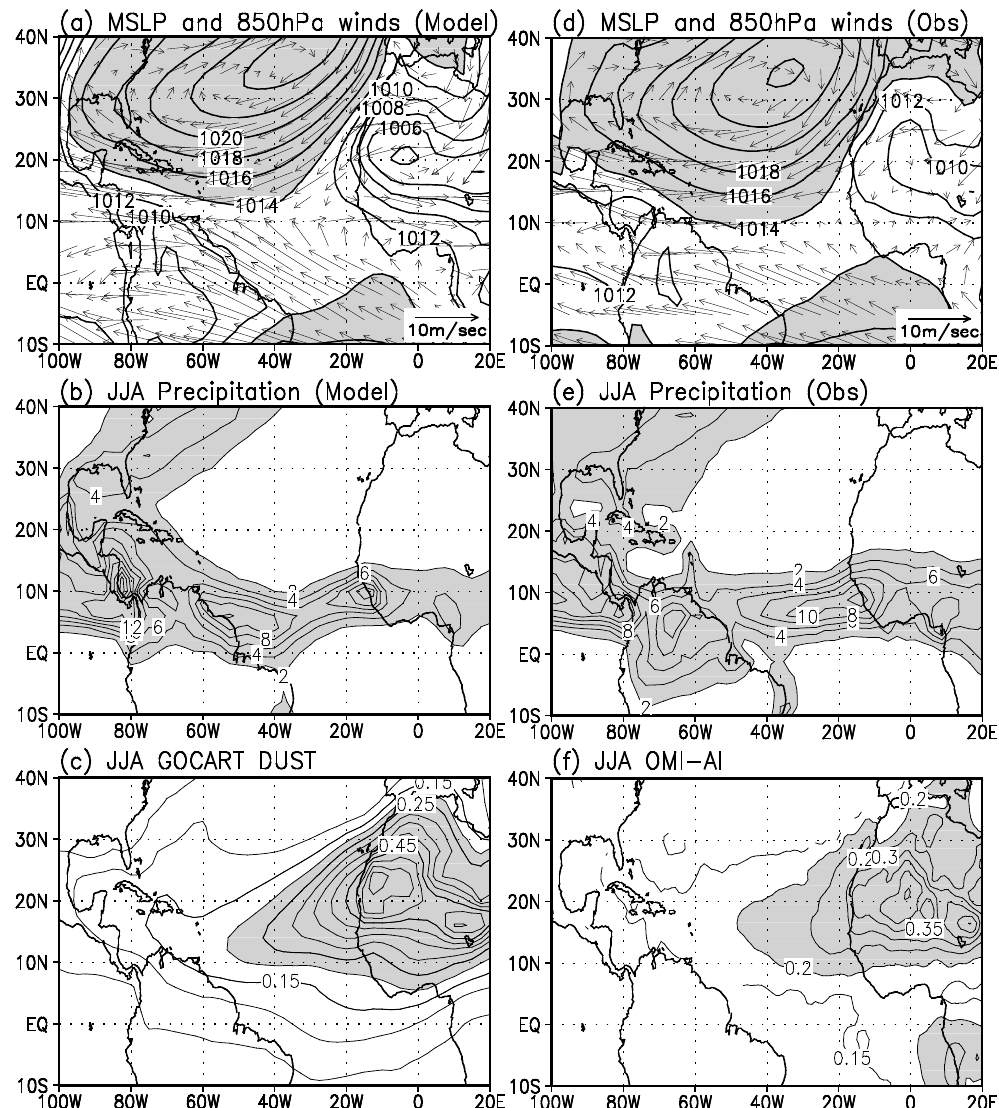
Fig. 1. JJA model climatology of (a) 850hPa wind (ms − 1 ) and mean sea level pressure (hPa), (b) rainfall (mm day − 1 ) from control run (AA), compared with corresponding observation climatology from NCEP reanalysis and GPCP precipitation in (d) and (e) . JJA mean dust Figure 1 JJA model climatology of a) 850 hPa wind (ms -1 ) and mean sea level pressure (hPa), aod from GOCART and TOMS-AI are shown in (c) and (f) , respectively. b) rainfall (mm day -1 ) from control run (AA), compared with corresponding e.g., National Center for Environmental Prediction observation climatology from NCEP reanalysis and GPCP precipitation in d) and e). JJA mean dust aod from GOCART and TOMS-AI are shown in c) and f), respectively.